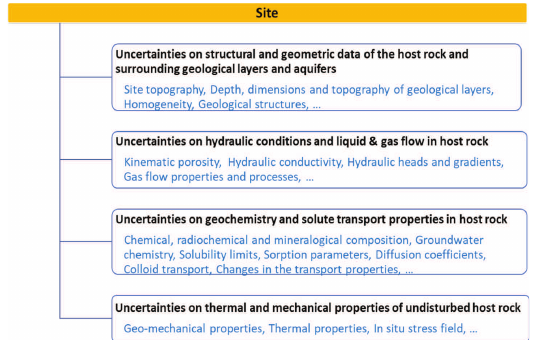
Fig. 3. Site specific uncertainties representing the third level of the classification